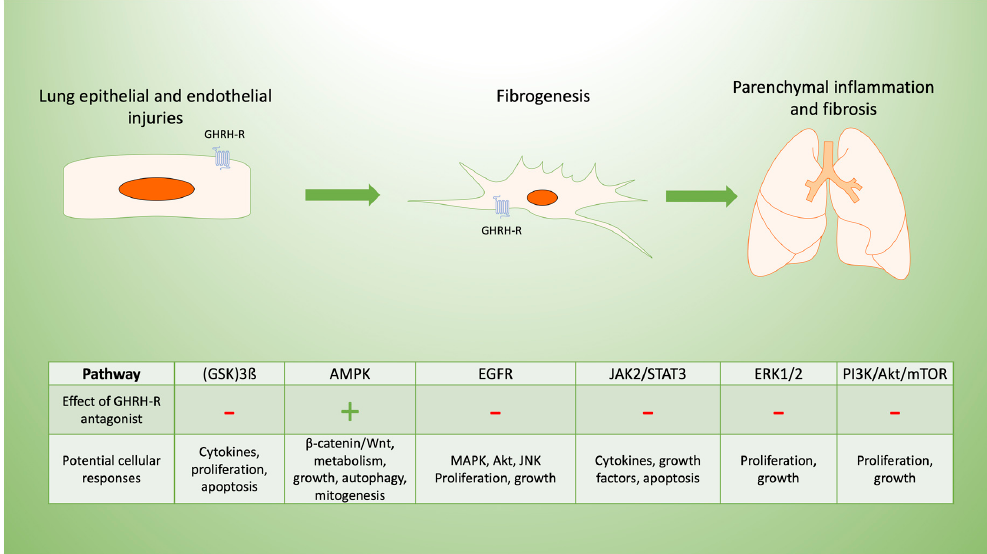
Figure 2. Potential mechanisms of GHRH-R antagonist in lung inflammation and fibrosis. Pulmonary fibrosis typically results from cellular injuries that may be followed by inflammation and progressive fibrosis. GHRH-R is present in lung tissue, and GHRH has e ff ects on lung cellular functions potentially mediated by diverse signaling pathways. These are involved in the lung’s response to inflammation and resulting fibrosis, which may be in response to epithelial injuries as shown diagrammatically above. GHRH-antagonist peptides maintain endothelial barrier function disrupted by inflammation, as they downregulate extracellular signal related kinase (ERK1 / 2) and Janus kinase-signal transducer and activator of transcription (JAK2 / STAT3). In lung epithelial cells, GHRH-R antagonist peptides activate adenosine monophosphate-activated protein kinase (AMPK) and glycogen synthase kinase 3 B (GSK3B) while inhibiting Akt / mammalian target of rapamycin (mTOR) and modulating cellular injury. Similarly, GHRH-R antagonist has anti-proliferative e ff ects in several lung cancer cell lines, which are mediated by epidermal growth factor receptor (EGFR) pathways.